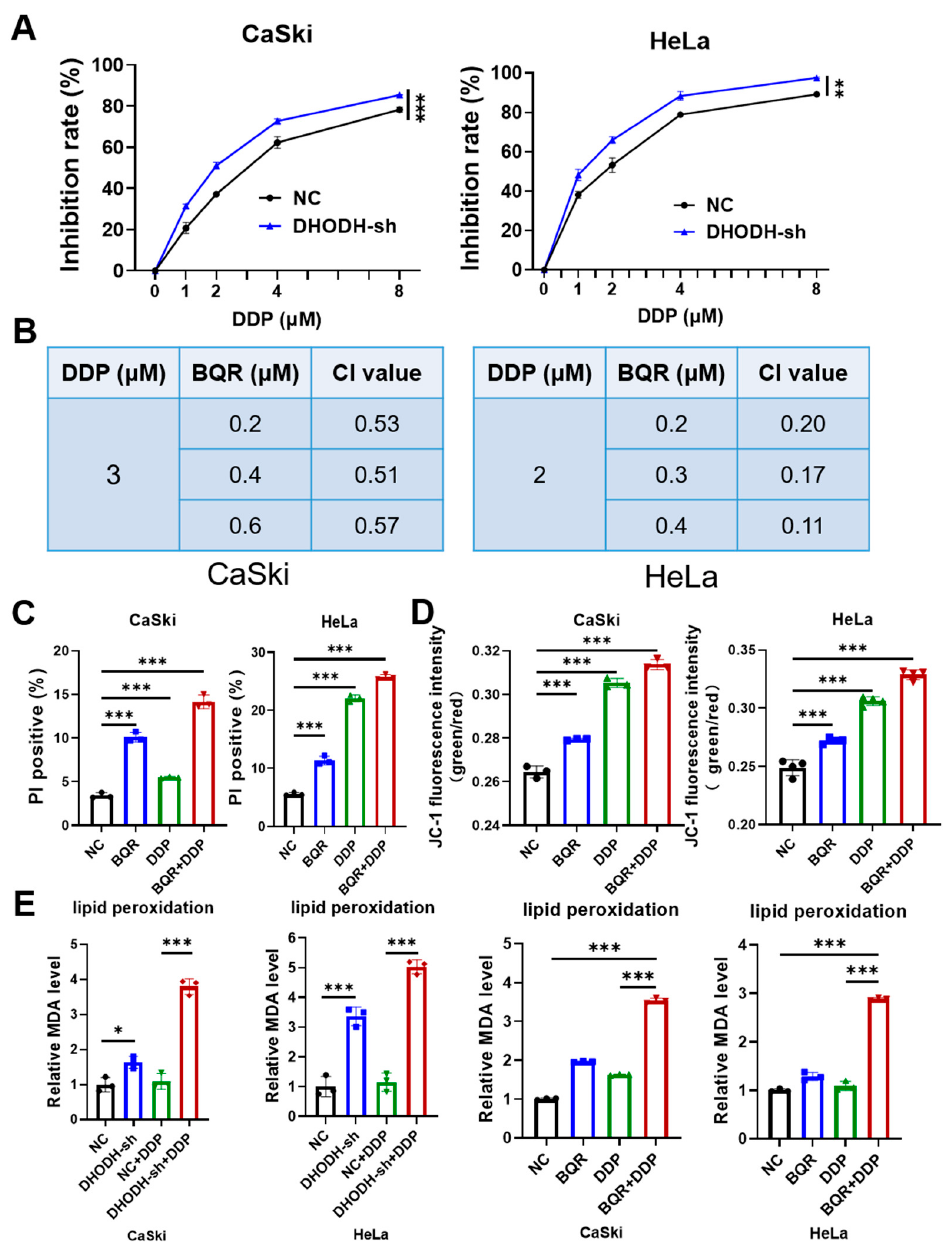
Figure 3. Brequinar (BQR) synergizes with cisplatin (DDP) to exert anticancer effects by inducing ferroptotic death in cervical cancer cells in vitro. ( A ) Cell viability of CaSki and HeLa cells treated with BQR (0.2 μ M for CaSki cells; 0.1 μ M for HeLa cells) and/or DDP (2 μ M for CaSki cells; 1 μ M for HeLa cells) for 48 h was measured by CCK-8 assays. ** p < 0.01, *** p < 0.001 compared to the control group. ( B ) The synergistic effect of BQR (0.2 μ M for CaSki cells; 0.1 μ M for HeLa cells) and DDP (2 μ M for CaSki cells; 1 μ M for HeLa cells) was measured in CaSki and HeLa cells. ( C ) The effect of combination of BQR (0.2 μ M for CaSki cells; 0.1 μ M for HeLa cells) and DDP (2 μ M for CaSki cells; 1 μ M for HeLa cells) on cell death in cervical cancer cells was assessed by flow cytometry analysis through PI staining. *** p < 0.001. ( D ) The mitochondrial dysfunction in CaSki and HeLa cells treated with BQR (0.2 μ M for CaSki cells; 0.1 μ M for HeLa cells) and/or DDP (2 μ M for CaSki cells; 1 μ M for HeLa cells) was measured by mitochondrial membrane potential detection through JC-1 staining. *** p < 0.001. ( E ) The synergistic effect of DHODH inhibition ( DHODH knockdown or BQR (0.2 μ M for CaSki cells; 0.1 μ M for HeLa cells)) and DDP (2 μ M for CaSki cells; 1 μ M for HeLa cells) on lipid peroxidation was measured by MDA level detection in cervical cancer cells. * p < 0.05, *** p < 0.001.